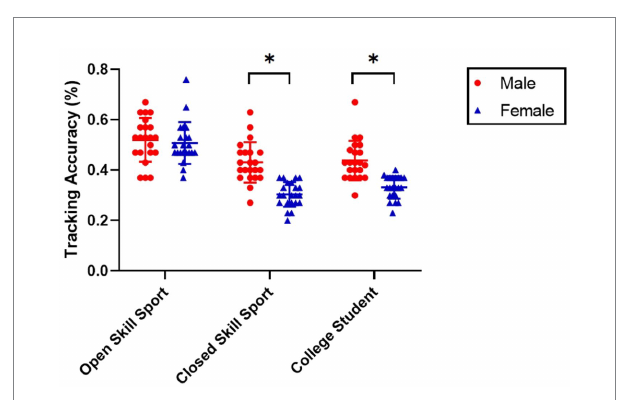
FIGURE 2 Comparison of the tracking accuracy between groups. * p <0.05.